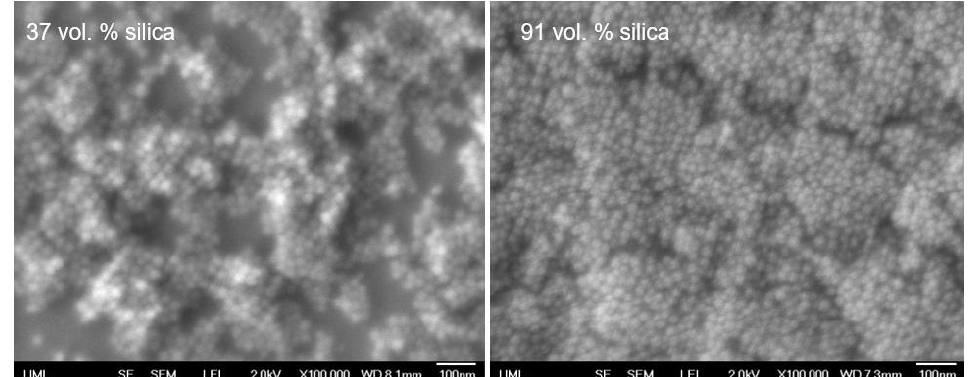
Figure 4. SEM images of coatings with particle loading (vol. %) of ( a ) 37, ( b ) 53, ( c ) 70, ( d ) 77, ( e ) 84. The inset is zoom-in SEM image.